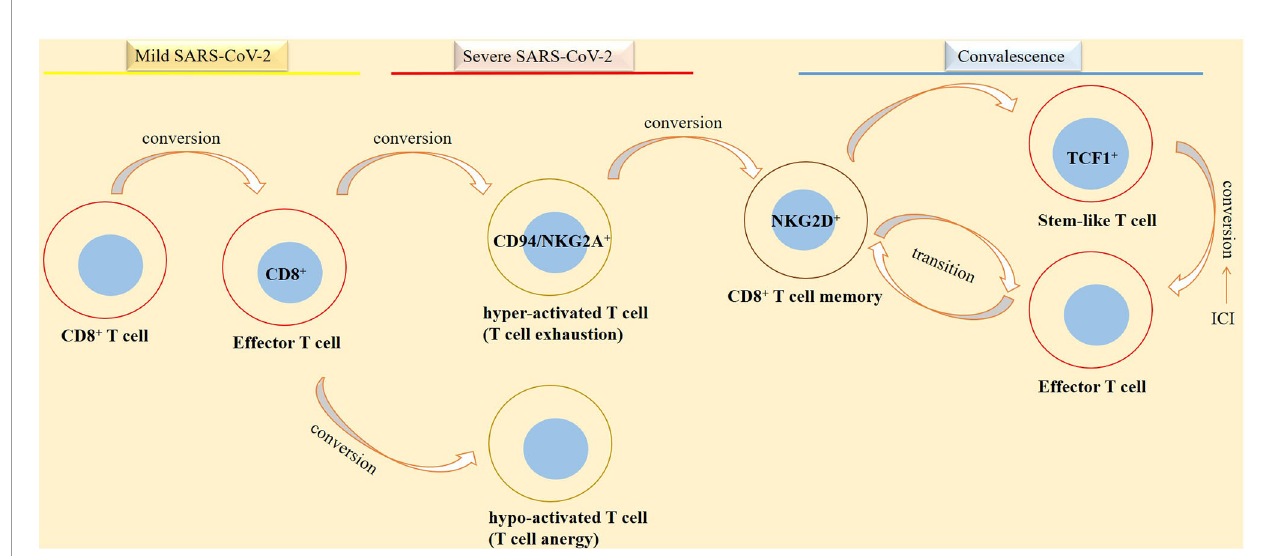
FIGURE 5 | Phases of SARS-CoV-2 induced disease in relation with CD8 + T-cell activity. CD8 + T cells take diverse functionality in different phases of SARS-CoV-2 induced disease. In patients with a mild disease CD8 + T cells are converted into functional effector cells for taking action against the virus. By contrast, in patients with a severe disease, CD8 + T cells are converted into either a hyperactive or a hypo-active phenotype, designated by the respective exhaustive and anergic cellular state with both representing T-cell dysfunctionality against the virus. In convalescent individuals from a SARS-CoV-2-induced disease, there is a different story. In such cases, stem-like and effector cells are formed in order for promoting action against viral reentry or reducing the hazard effect of the virus on tissues or